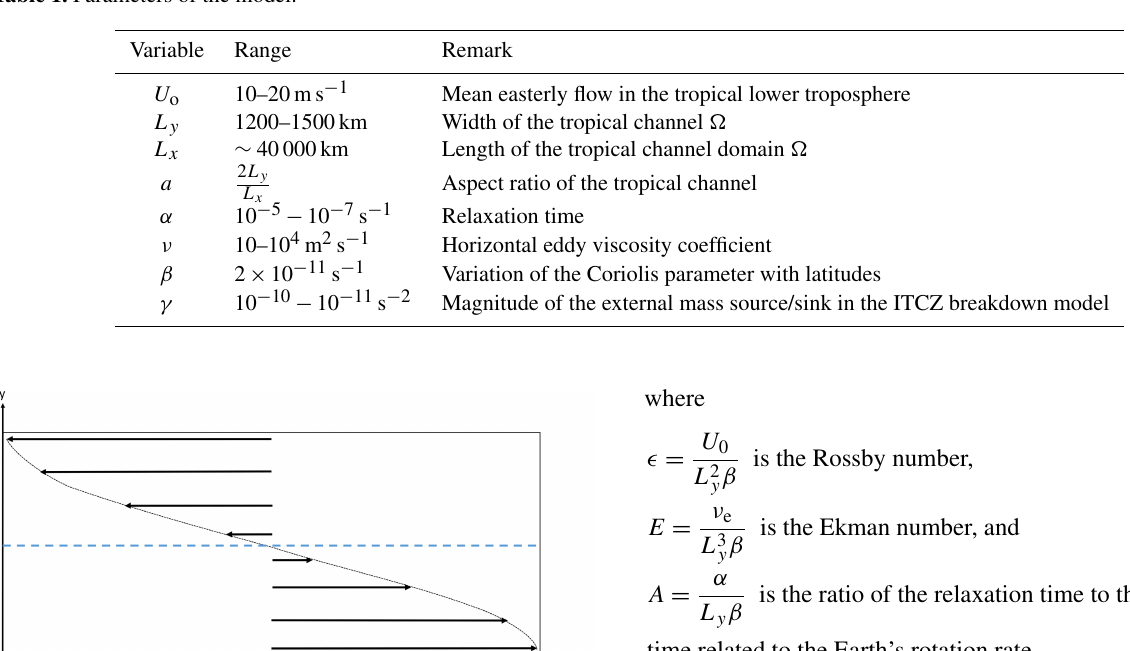
Table 1. Parameters of the model.